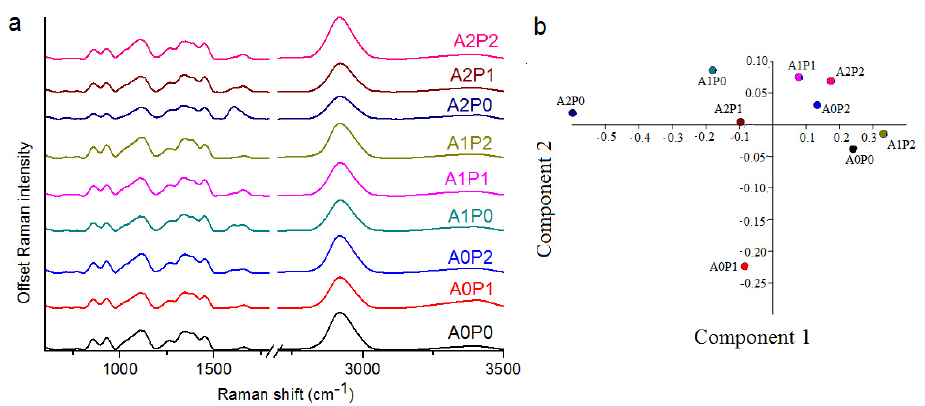
Figure 13. ( a ) FT-Raman spectra of oat grains (2017); ( b ) PCA analysis of FT-Raman spectra of oat grains in 800–1800 cm − 1 where A0P0—no fertilizer, no magnetostimulation; A0P1—no fertilizer, short magnetostimulation; A0P2—no fertilizer, longer magnetostimulation; A1P0—average dose of algae, no magnetostimulation; A1P1—average dose of algae, short magnetostimulation; A1P2—average dose of algae, longer magnetostimulation; A2P0—maximum dose of algae, no magnetostimulation; A2P1—maximum dose of algae fertilizer, short magnetostimulation; A2P2—maximum dose of algae, longer magnetostimulation.